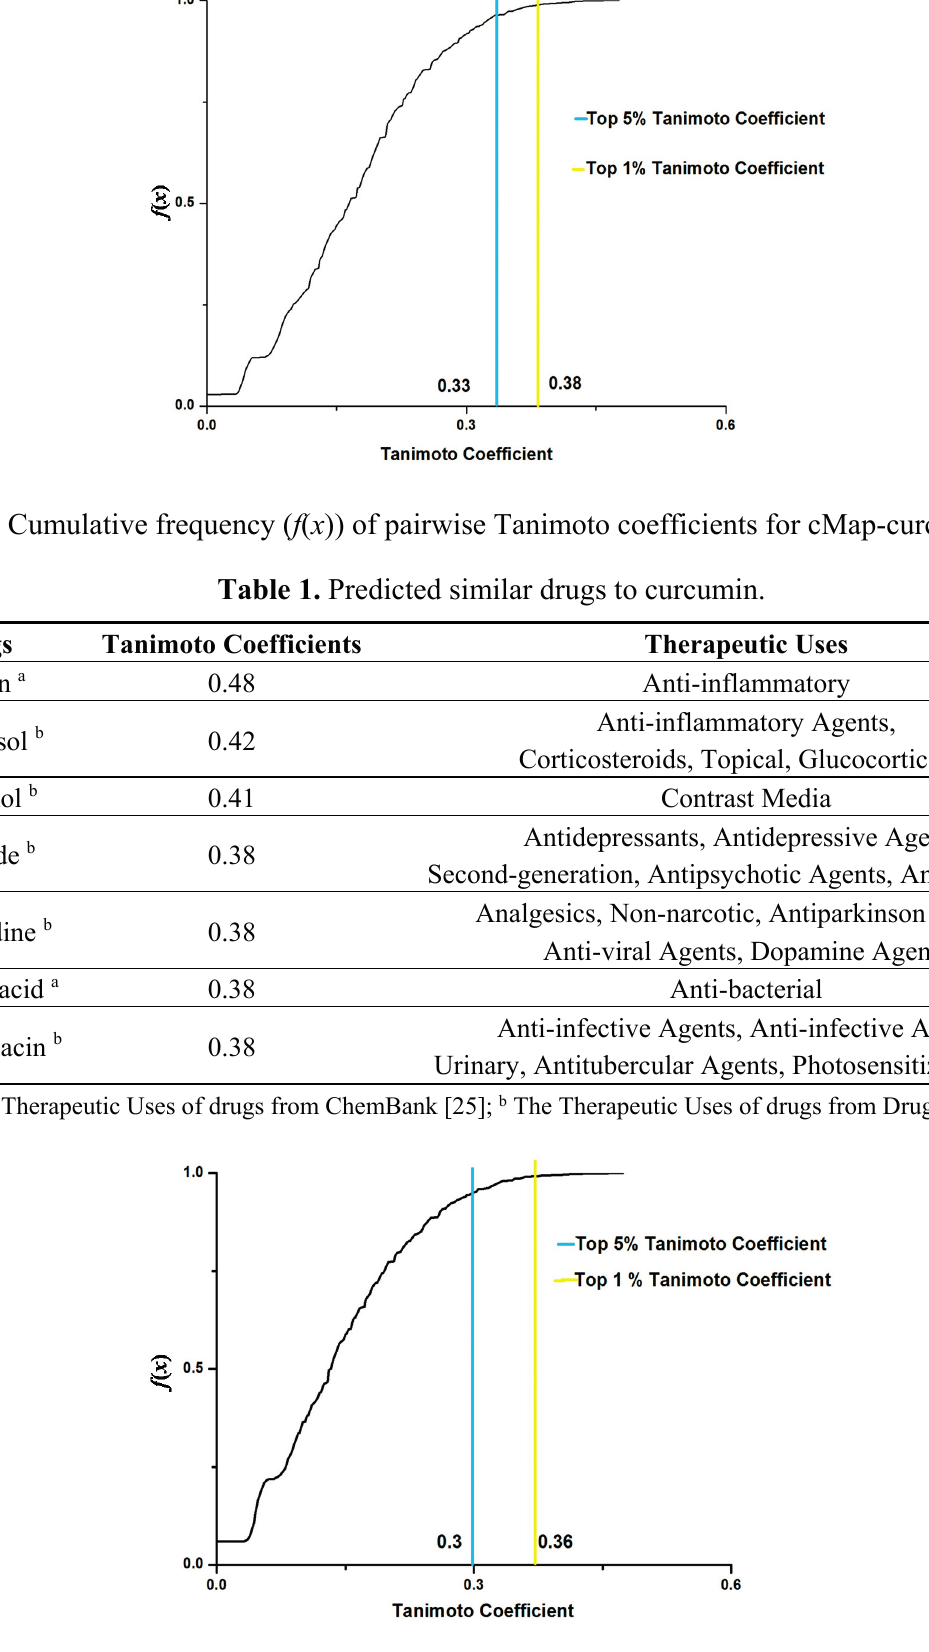
Figure 5. Cumulative frequency ( f ( x )) of pairwise Tanimoto coefficients for cMap-Si-Wu-Tang